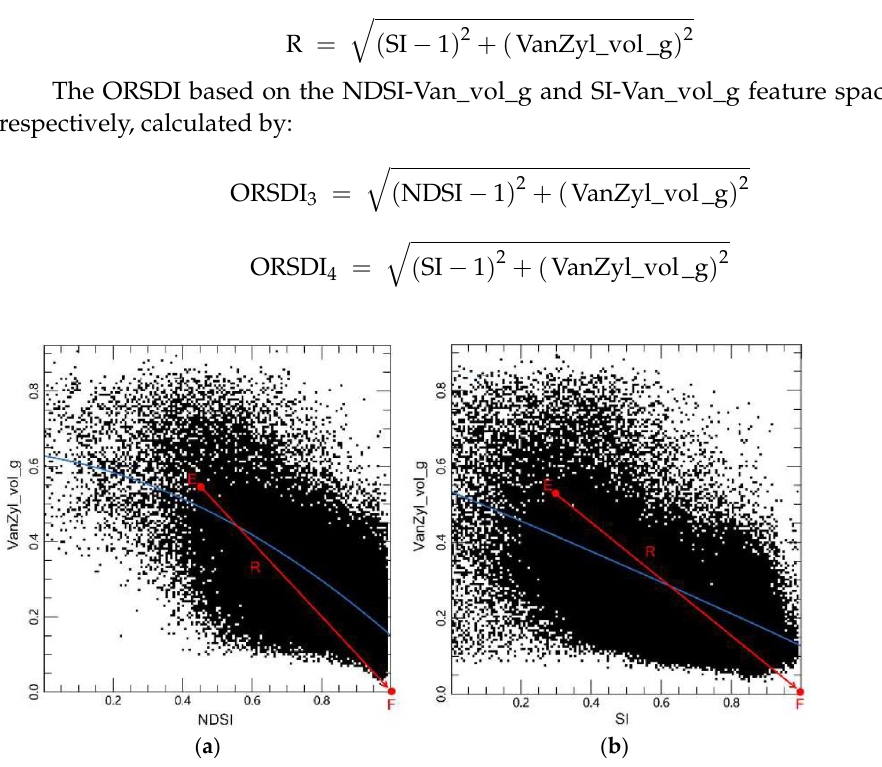
Figure 11. Construction of the salt-radar models: ( a ) NDSI-VanZyl_vol_g feature space; ( b ) SI- VanZyl_vol_g feature space. (The blue line is the trend line between the components; the red line R is the distance from any point E in the feature space to F (1,0)).